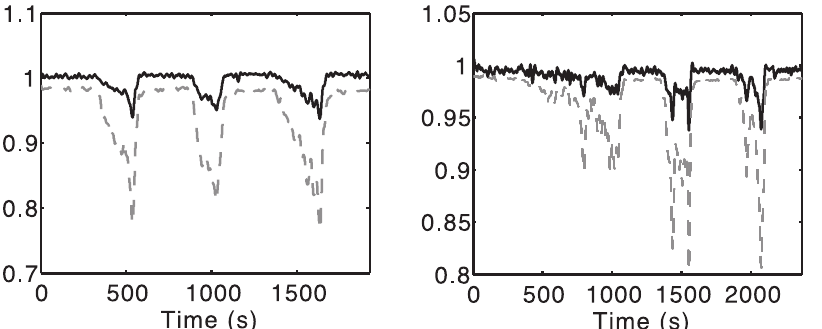
Figure 6. Two examples of measured SaO 2 and model-predicted CMRO 2 during an experiment. The model predictions are without optimisation. In each case the dashed line is SaO 2 as a ratio, while the bold line is CMRO 2 normalised to its initial value. Left. Subject 1. This is a fairly typical trace. Right. Subject 5. Both SaO 2 and CMRO 2 are more variable, but again the model predicts that CMRO 2 changes follow the trends in